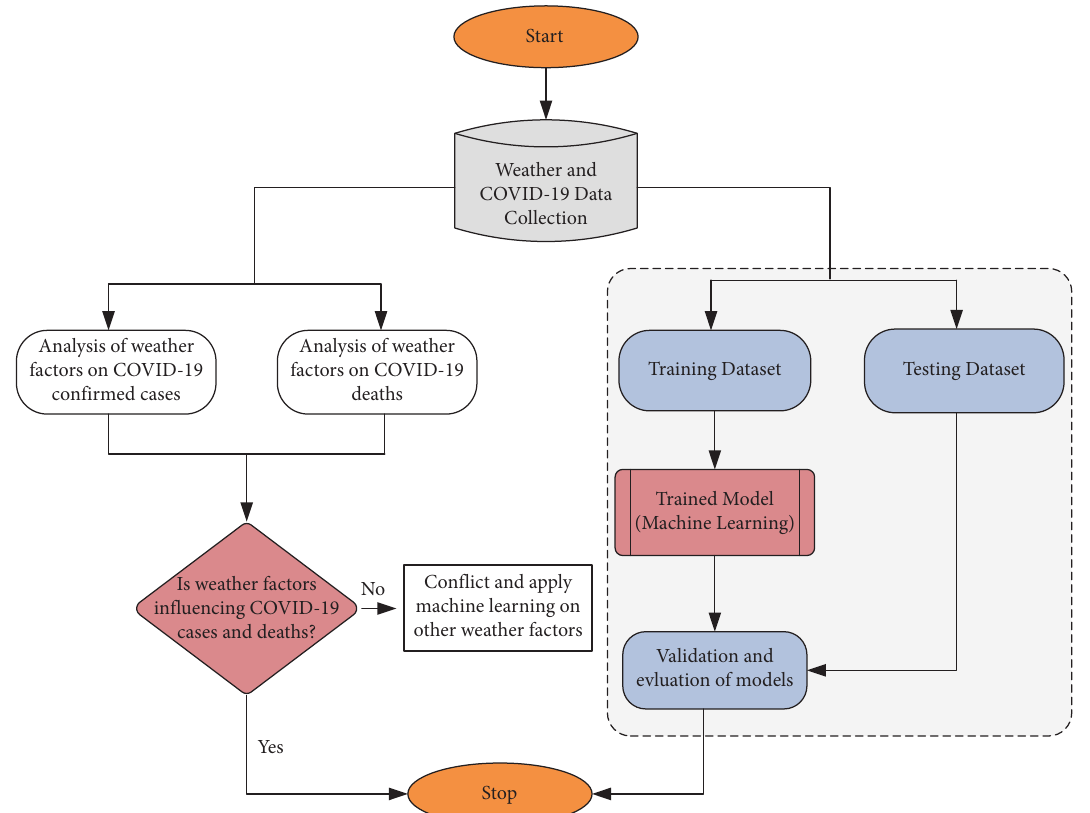
Figure 2: Methodology used in the present work.